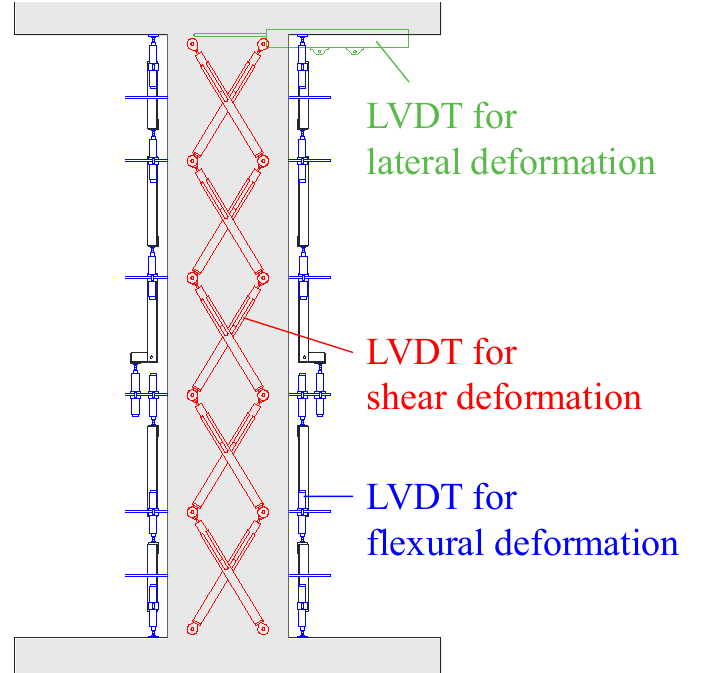
Figure 4. Details of measurement schemes (example of CM1).